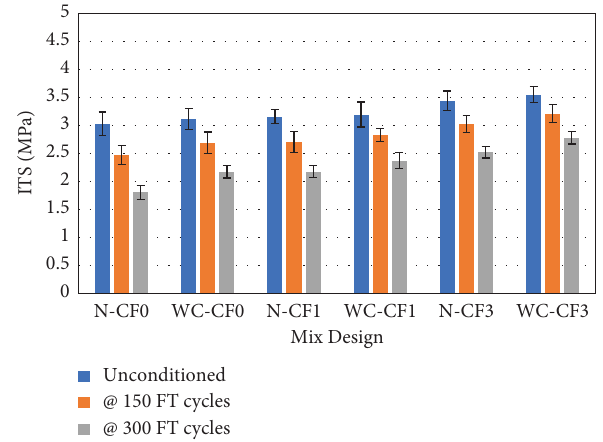
Figure 4: Results of 28-day indirect tensile